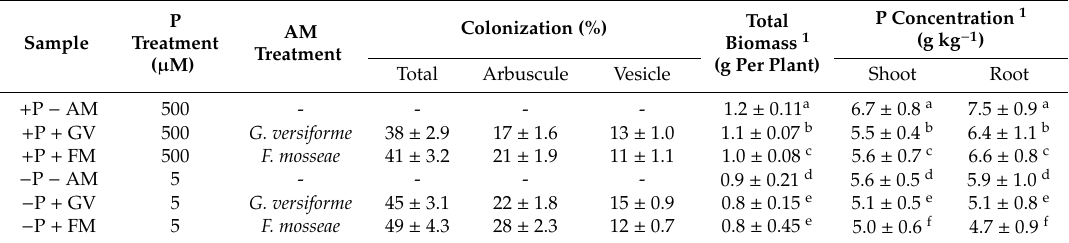
Table 1. AM colonization, growth and phosphorus (P) response of wheat inoculated with F. mosseae , G. versiforme or non-mycorrhizal for 6